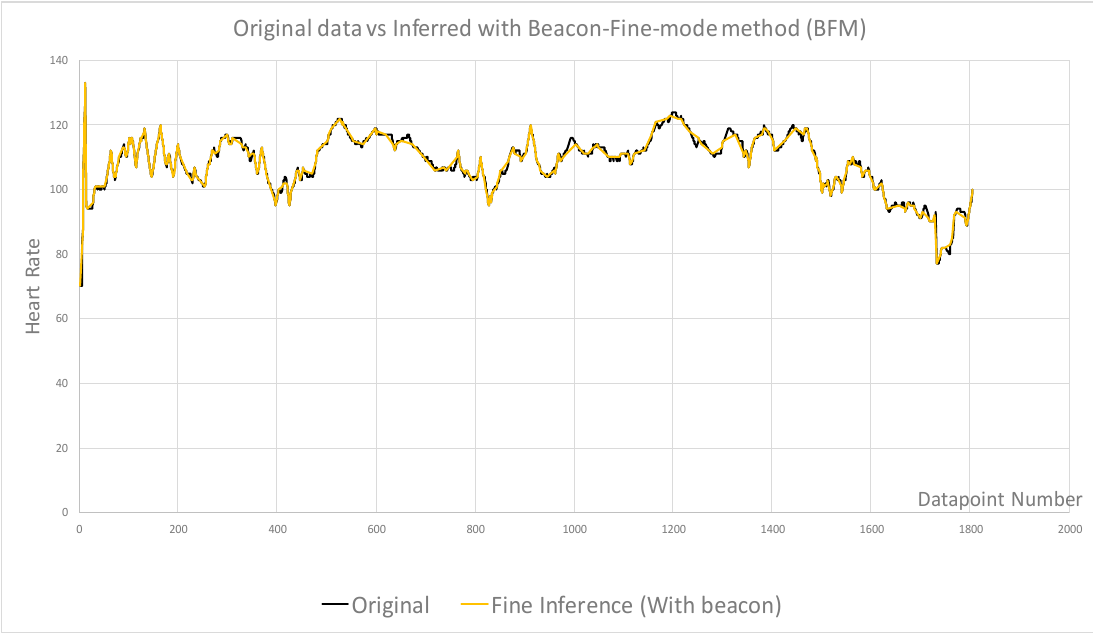
Figure 7. Original data points versus Beacon-Fine-mode method (BFM) applied for inference (original DP: 1800, inferred DP: 496). It has the greatest number of DPs, however, provides the best accuracy rate, representing the best outcome of the original DPs.